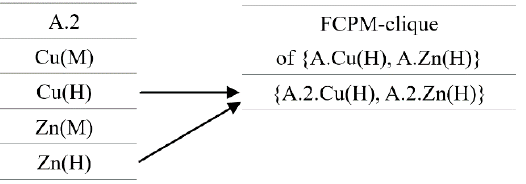
Figure 9. An example of constituting FCPM-cliques with only one instance.